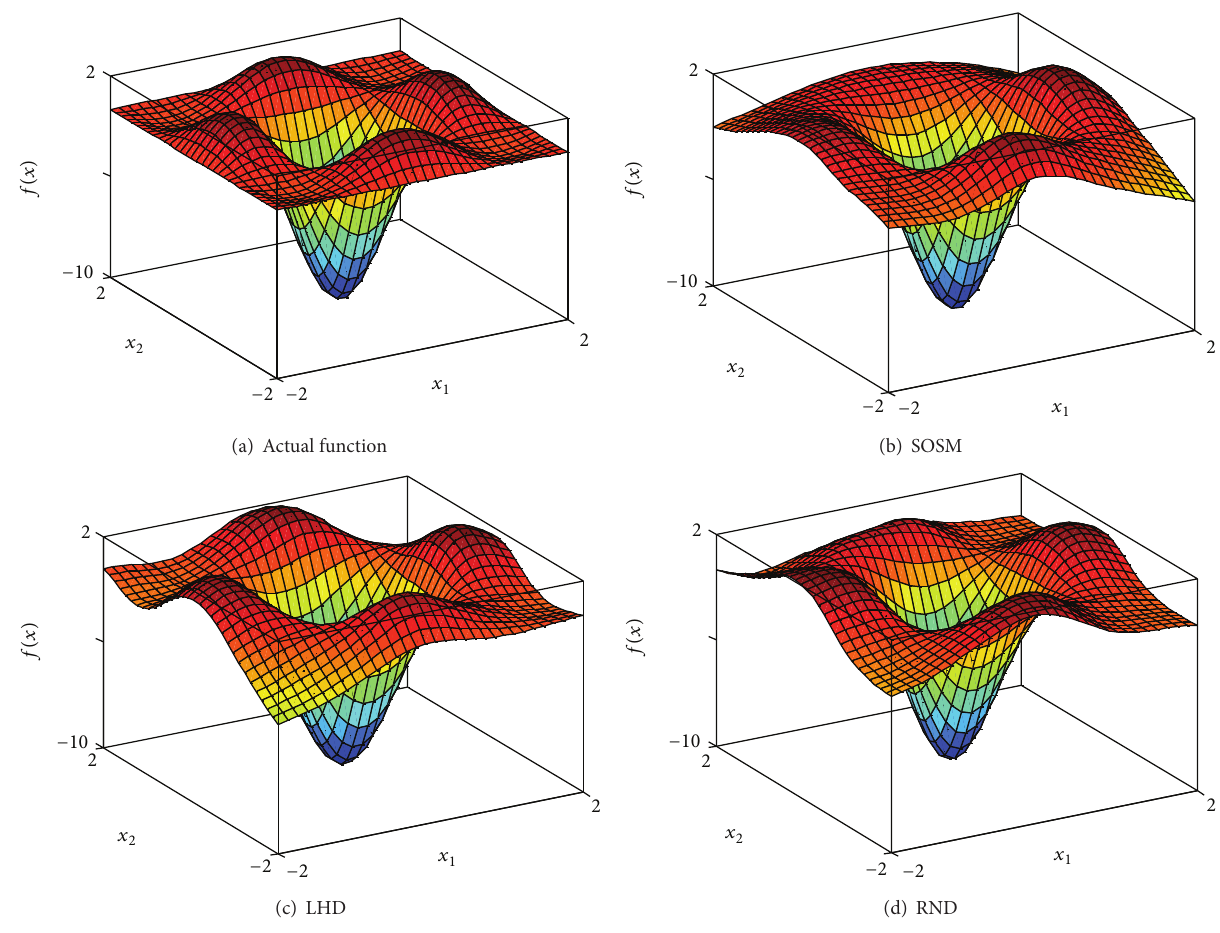
Figure 11: Function 1: actual and metamodel